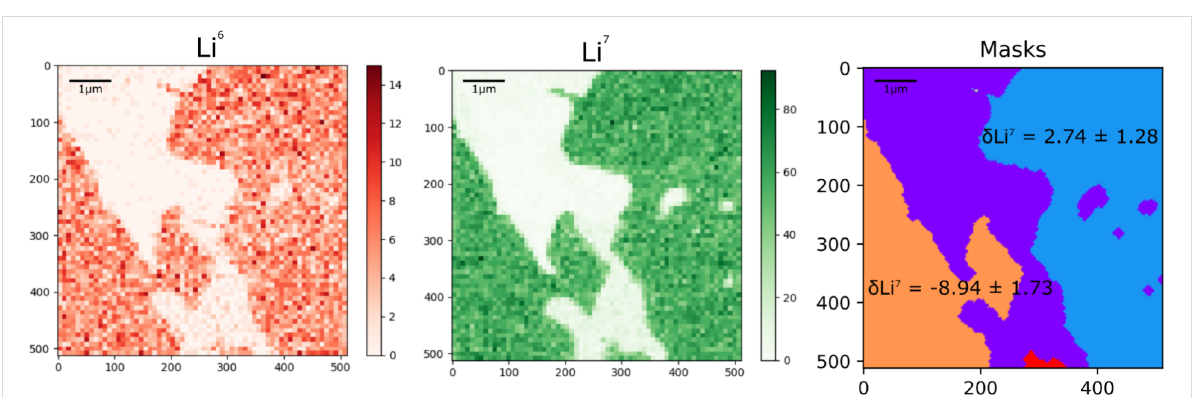
Figure 6: The relative δ 7 Li ratios for regions within the same grain of Spodumene as in Figure 4 and Figure 5. Four connected regions with roughly similar counts have been identified, the purple region, an altered region, shows no Li, whilst the red region contains too few pixels to calculate a δ 7 Li value with a reasonable error. Values are not calibrated to an external standard, but instead to the average ratio across all measurements of the grain, which should lead to values of zero for isotopically homogenous